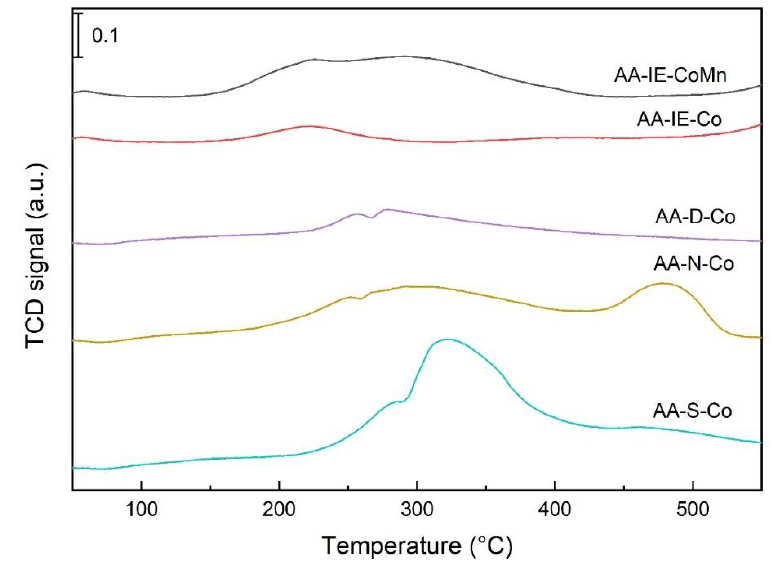
Figure 6. H 2 -TPR profiles of cobalt catalysts.